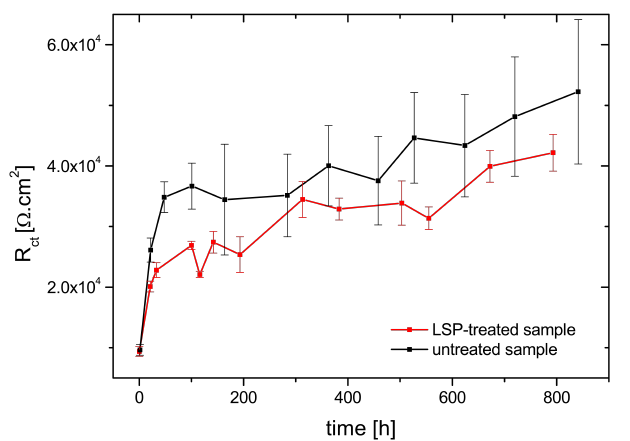
Figure 10. Evolution of the charge transfer resistance R ct during exposure of untreated and LSP- treated sample of AISI-304L in VVER environment at 280 ◦